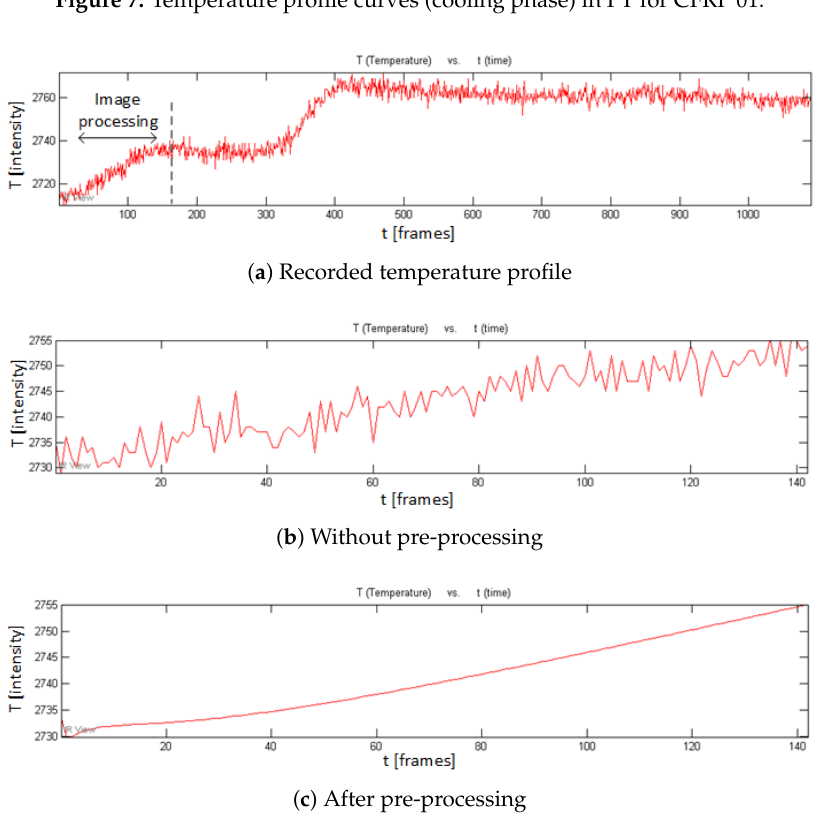
Figure 8. Temperature profile curves in VT for CFRP